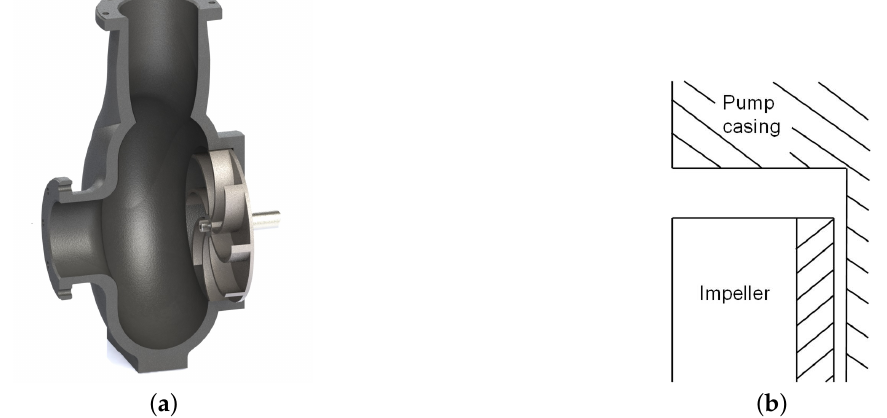
Figure 2. ( a ) Vortex pump according to the covered design; and ( b ) schematic illustration of the covered design.